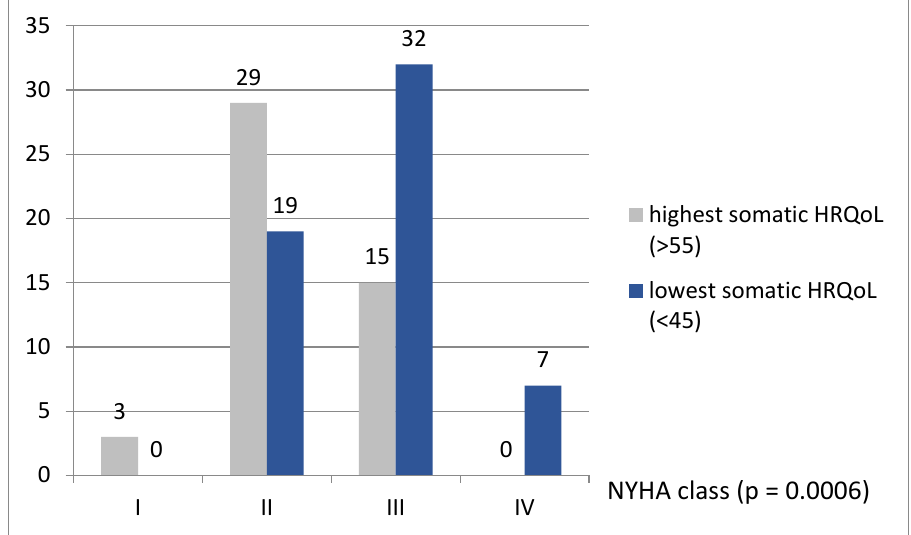
Figure 1. NYHA class in patients with highest and lowest somatic HRQoL score.